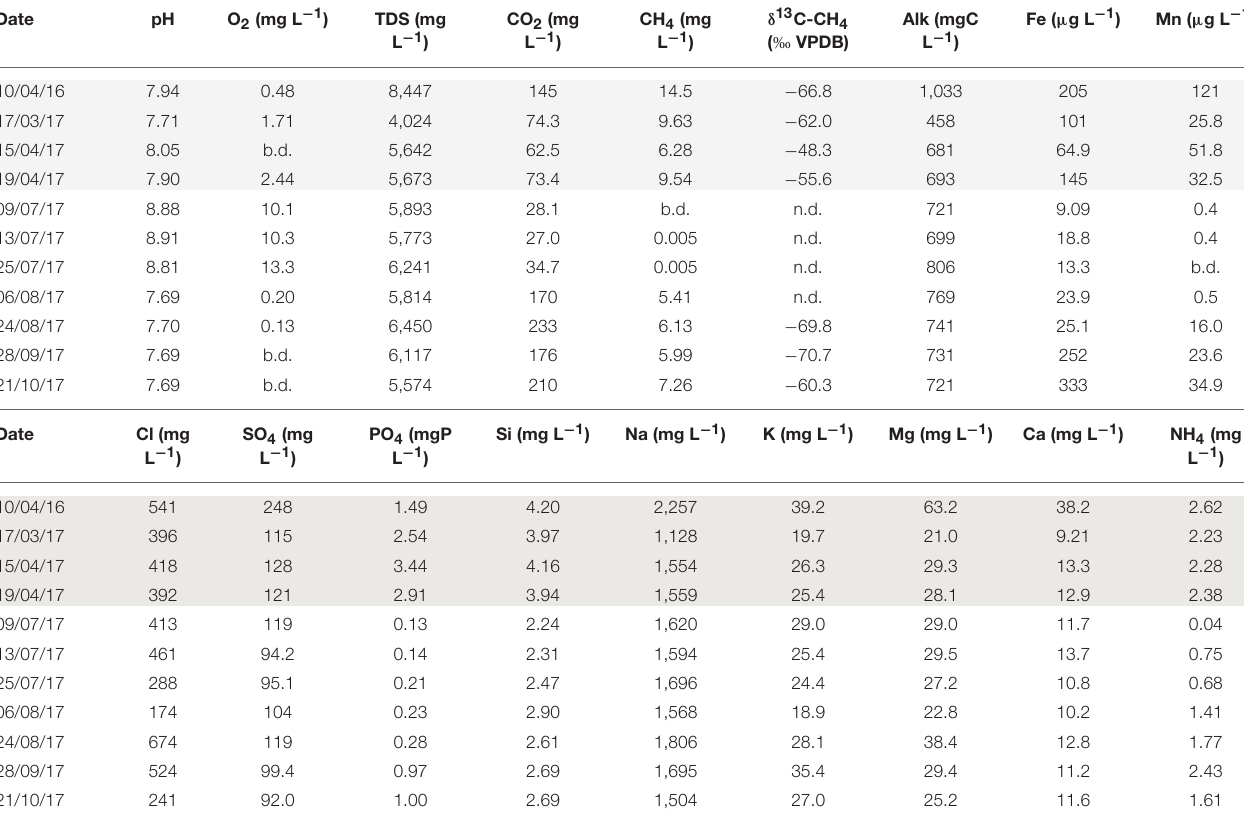
TABLE 1 | Geochemical characteristics of Lagoon Pingo surface waters (“b.d.” means below detection, “n.d.” means not